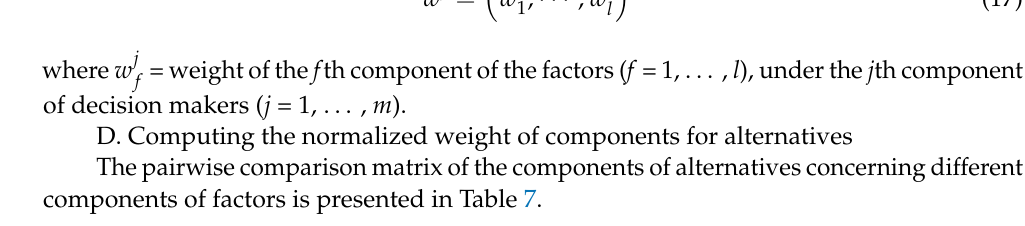
Table 7. Pairwise comparison of alternatives concerning different components of Factors.